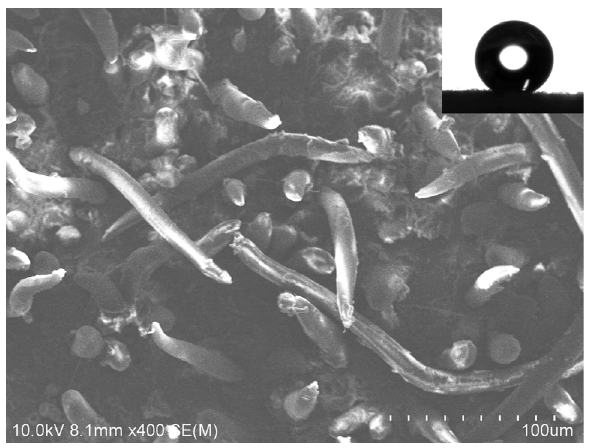
Figure 1: The SEM microgram of juicy peach surface and the profile of a water droplet on it.